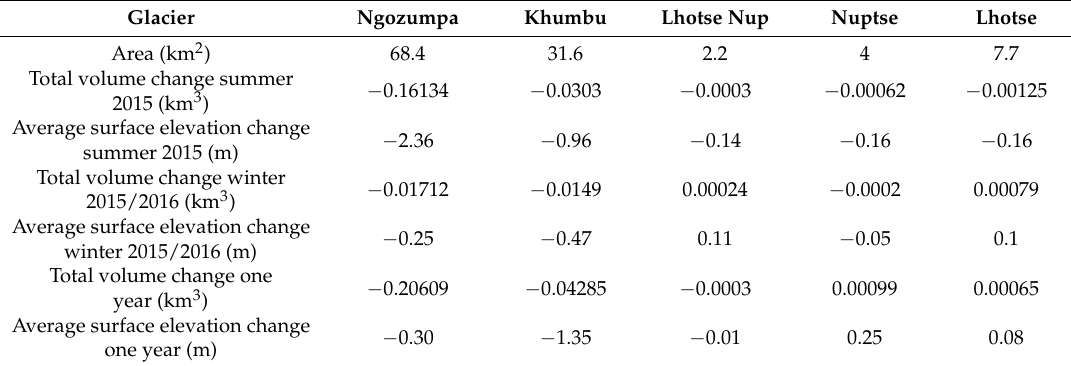
Table 5. Total volume change and average surface elevation change for the investigated glaciers and periods.